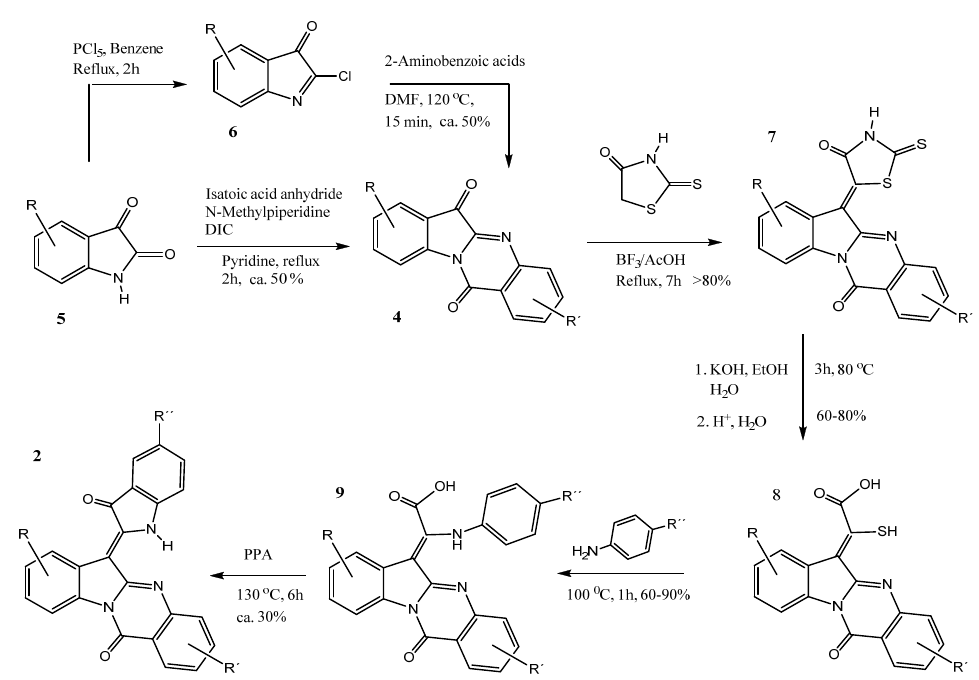
Scheme 1. Overview of all reactions of the quingdainone synthesis. The double bond (3-2’’) is portrayed with the correct Z-configuration. Precursors are also depicted with Z-configuration; however, E-configuration can be present as well.